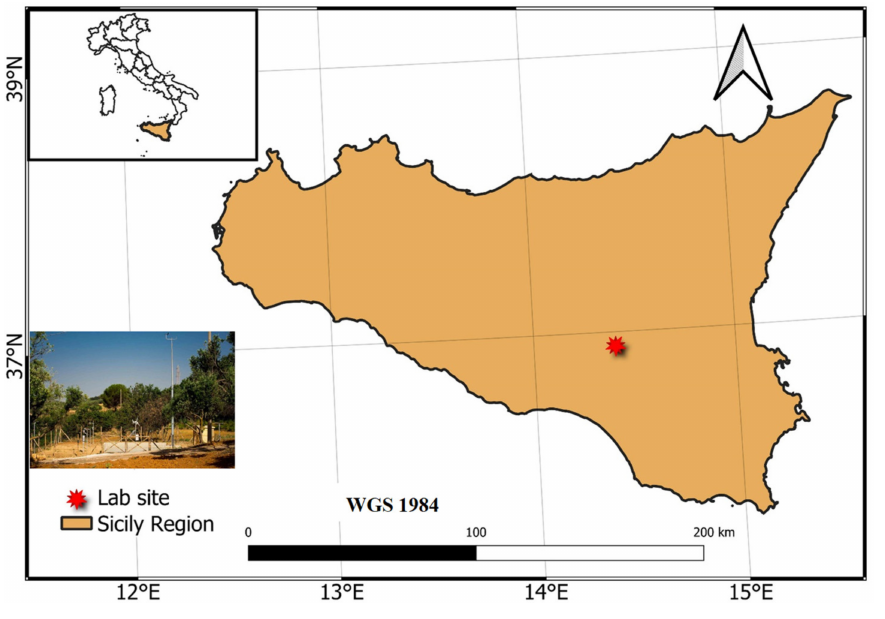
Figure 1. Location of the study